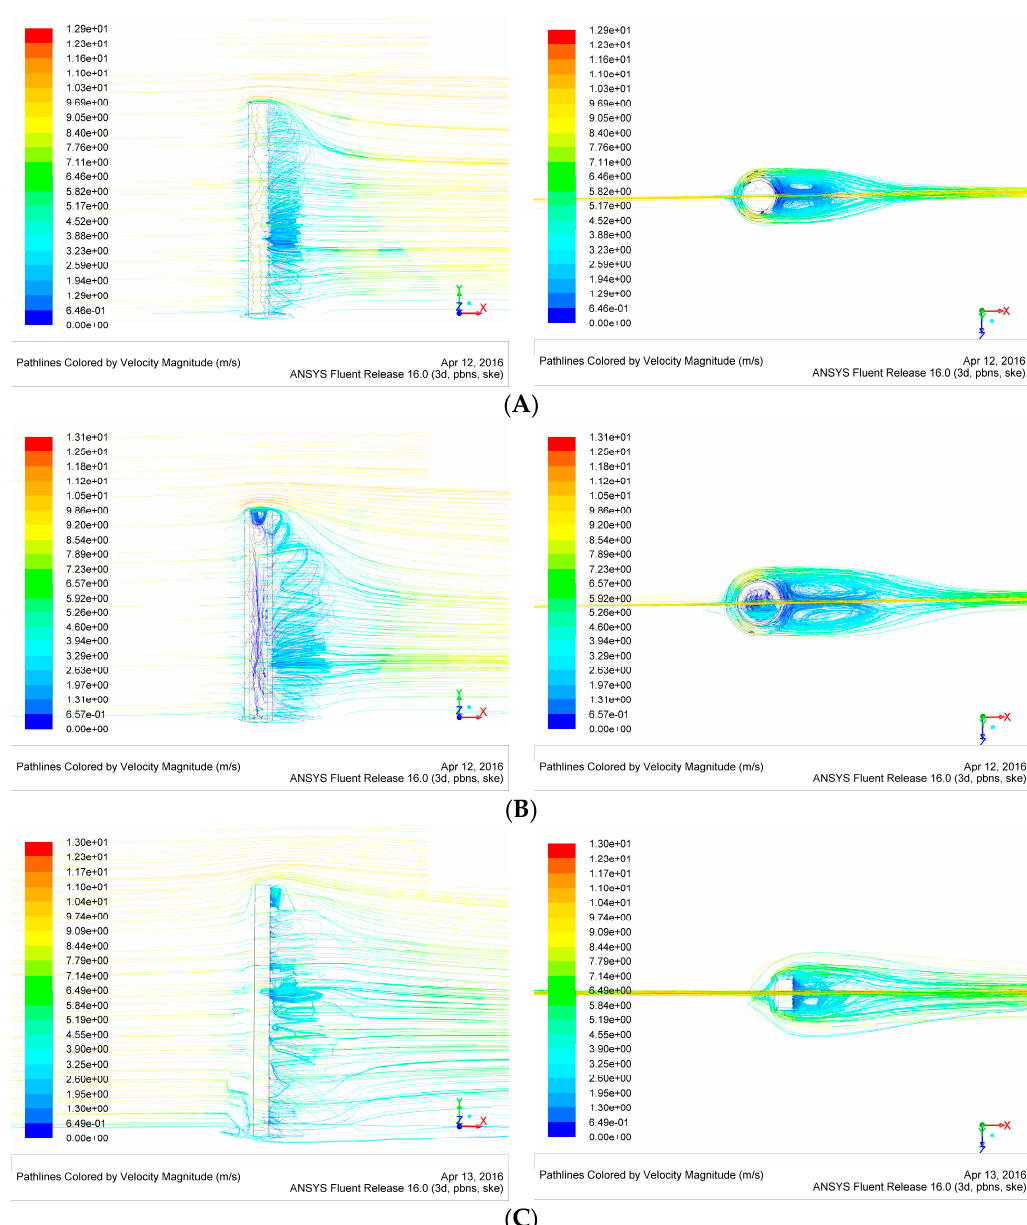
Figure 13. The air flow rate simulation of 10 m/s in different hair post shapes. ( A ) Circular hair post; ( B ) Hollow circular hair post; ( C ) Rectangle hair post.